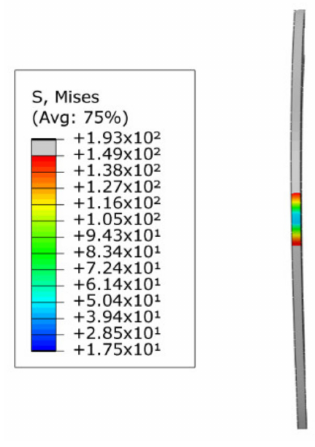
Figure 11. Tube cross-section